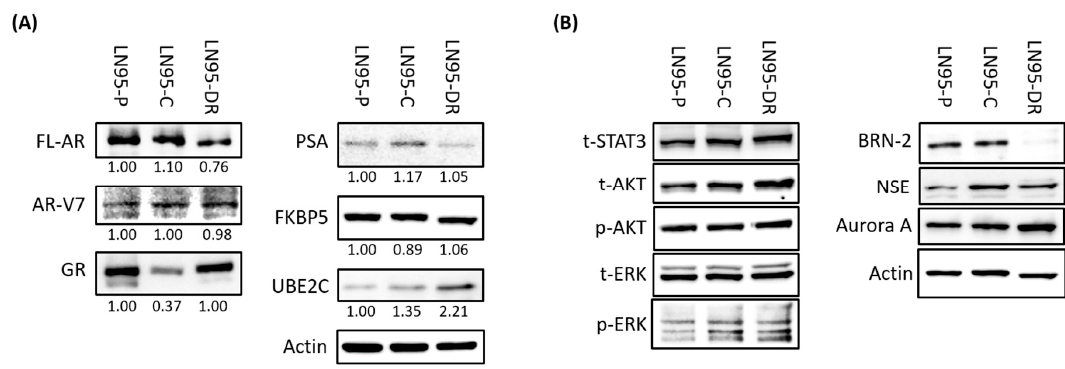
Figure 3. Levels of proteins suspected to play a role in the resistance to therapies for castration-resistant prostate cancer (CRPC). Western blot analyses using whole cell lysates from cell lines. Expression of proteins in androgen receptor (AR) and AR-V7 signaling ( A ), Jak/STAT, PI3K/AKT/mTOR, Ras/MAPK pathway and neuroendocrine markers ( B ). The ratio among the three cell lines was described, which was normalized to that in LN95-P, comparing the protein expression values of FL-AR and AR-V7 regulated molecules normalized to beta-actin as an internal control (A).